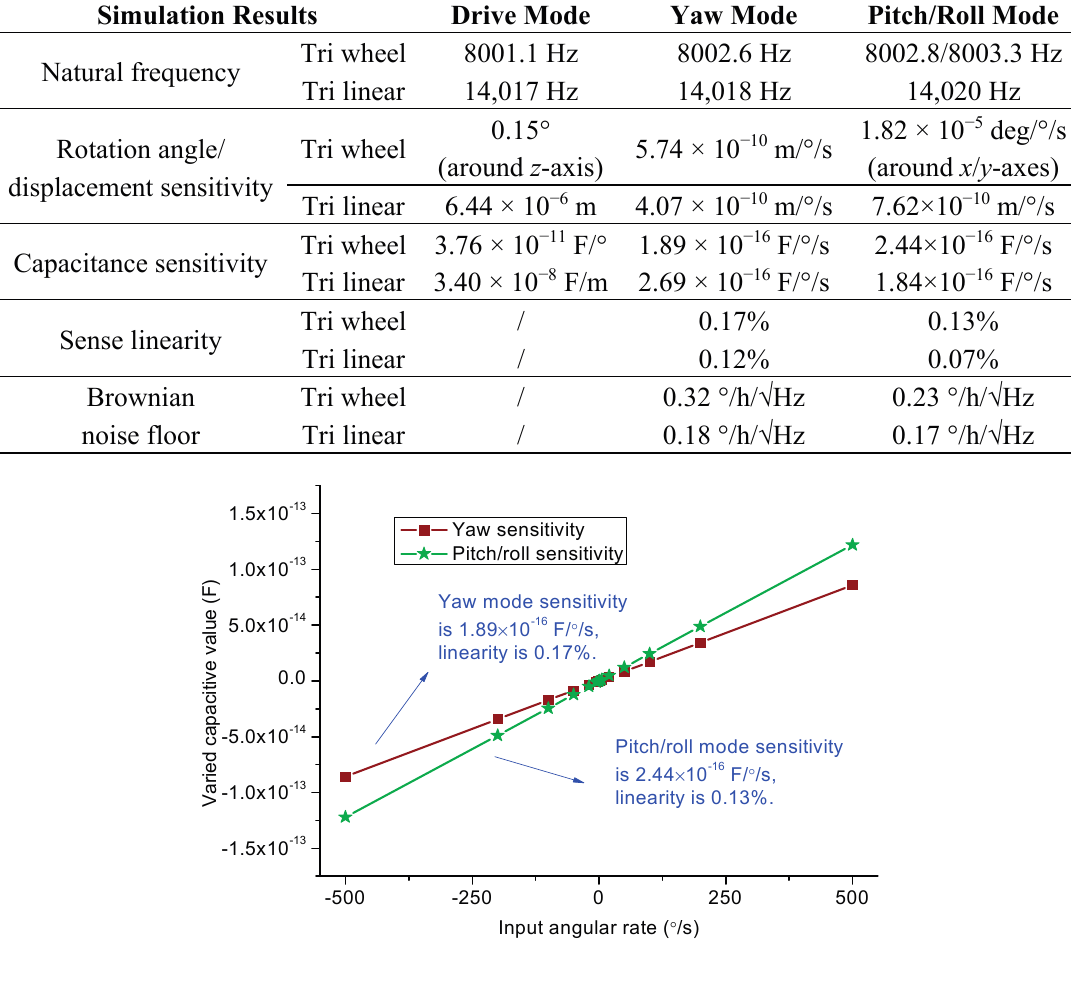
Figure 8. Sensitivity simulation